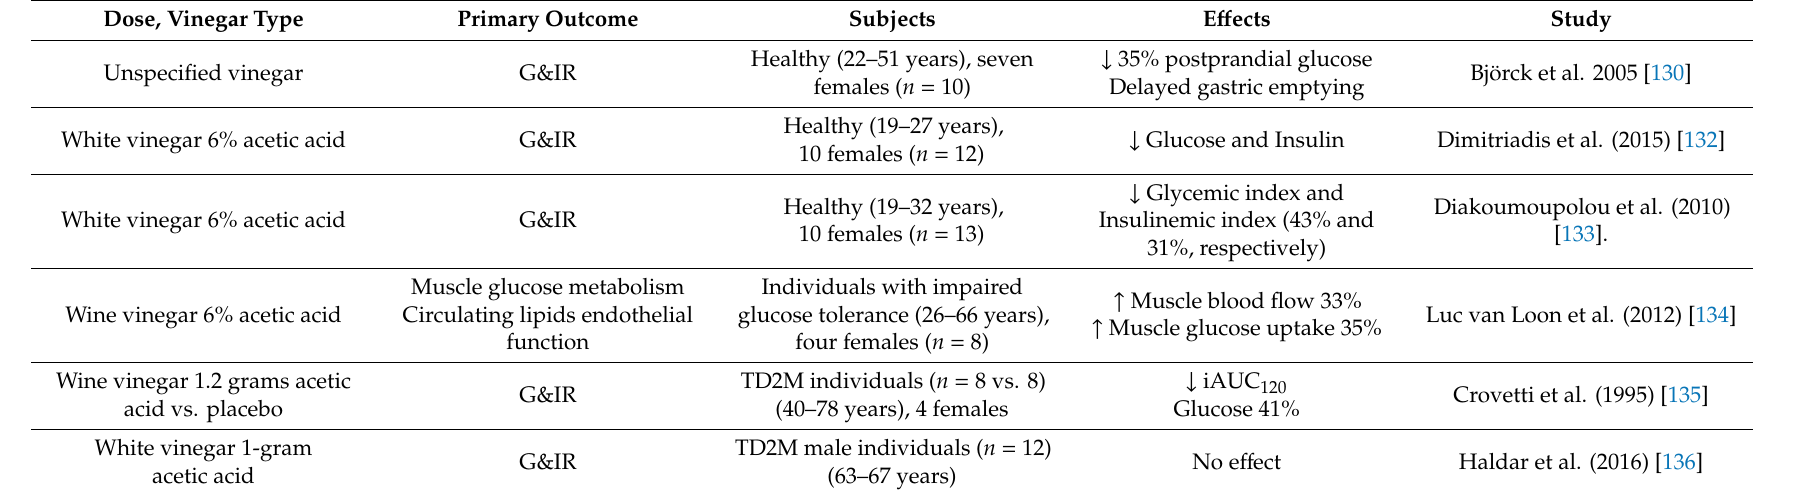
Table 3. Vinegar administrations in